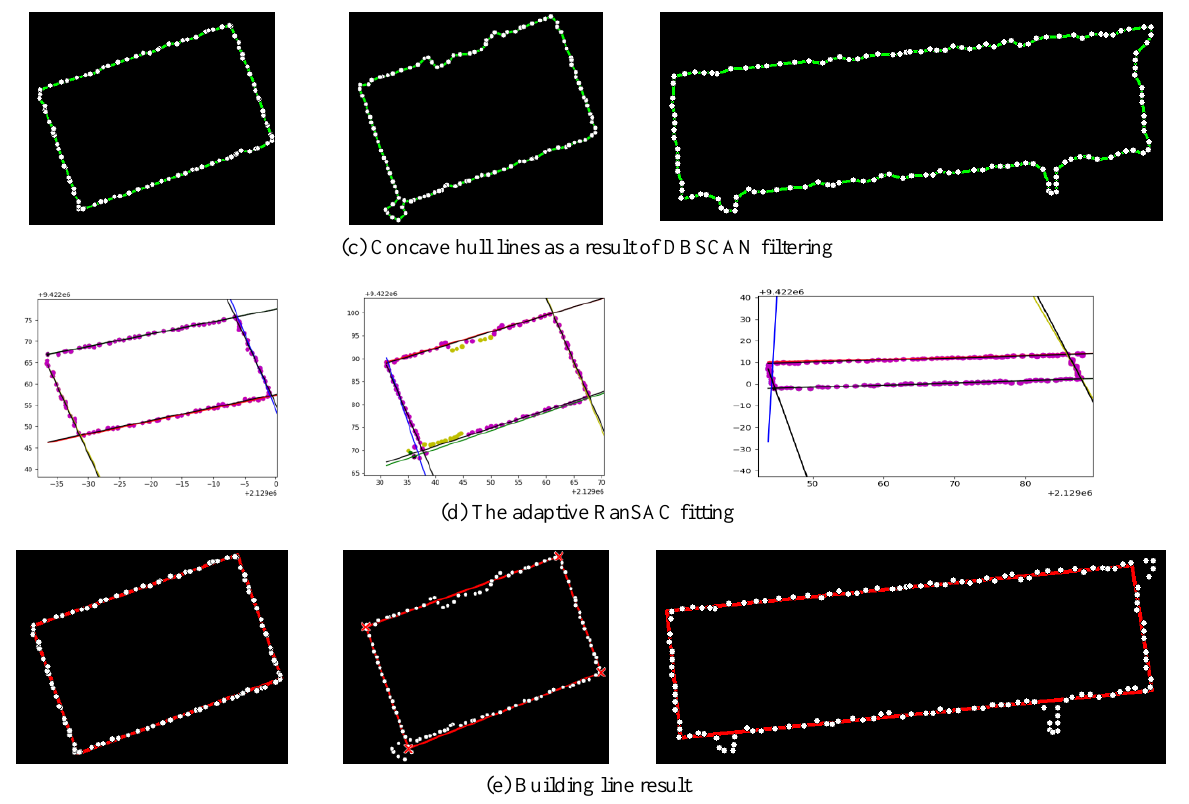
Figure 8. Illustration of the building outlines the